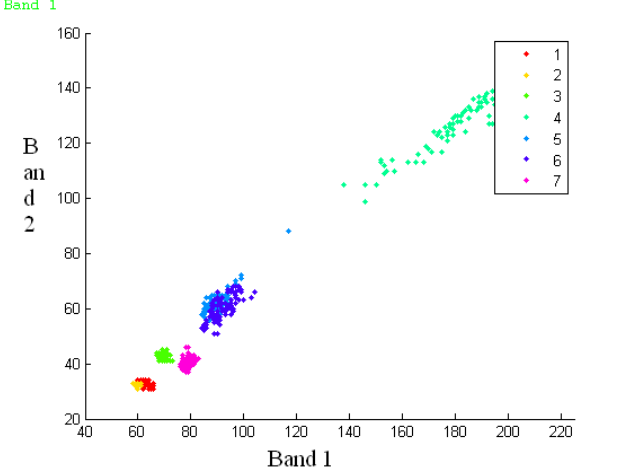
Figure 3: The scatter plot of the test samples for the proposed method for the IRS data